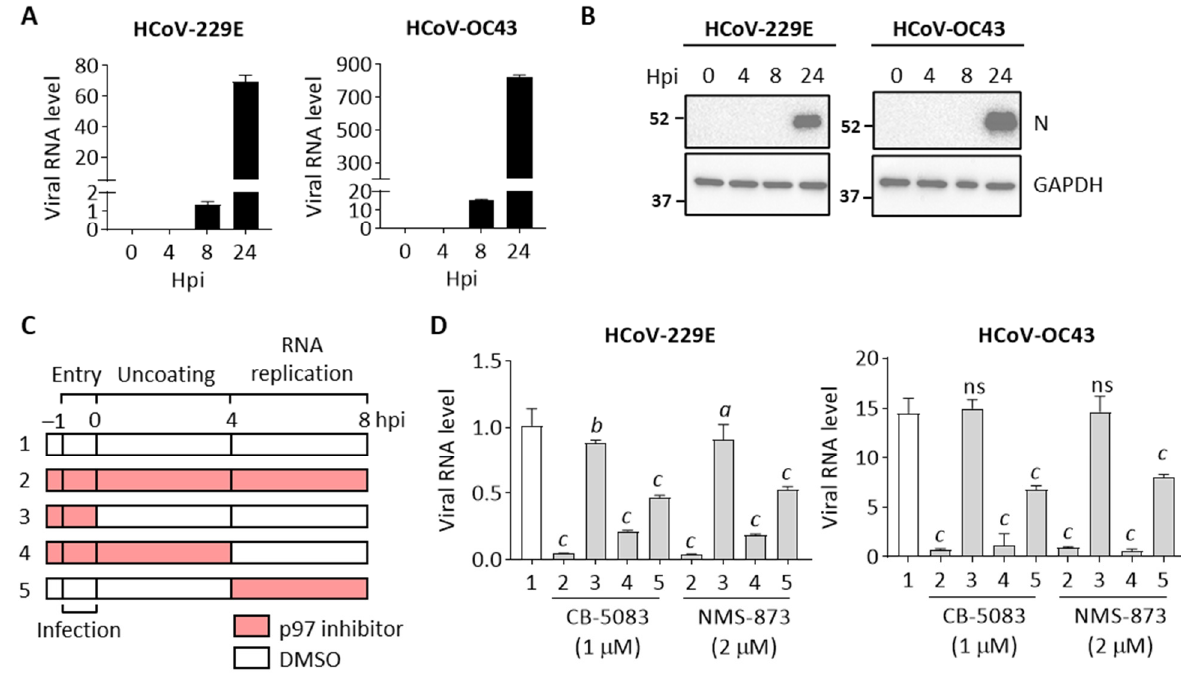
Figure 3. p97 is essential for early stages of HCoV replication. H1299 cells were infected with HCoV-229E (MOI 0.5) or HCoV-OC43 (MOI 0.01). ( A ) Quantification of viral RNA in cell lysates over time after infection. Data shows RNA levels relative to GAPDH. ( B ) Representative Western blot showing viral N protein and GAPDH expression in the infected cells. Full bot images are depicted in Supplementary Figure S5. ( C ) H1299 cells were continuously treated with DMSO or p97 inhibitors (CB-5083 and NMS-873) at the indicated period from 30 min before infection to 8 hpi and harvested to determine viral RNA levels. All conditions were performed in biological triplicate. ( D ) Quantification of viral RNA in the cell lysates harvested at 8 hpi. Data show relative RNA levels to GAPDH. Error bars represent SD ( n = 3). Statistical analysis was conducted with one-way ANOVA compared to group 1: a , p < 0.01; b , p < 0.001; c , p < 0.0001; ns, no significance.